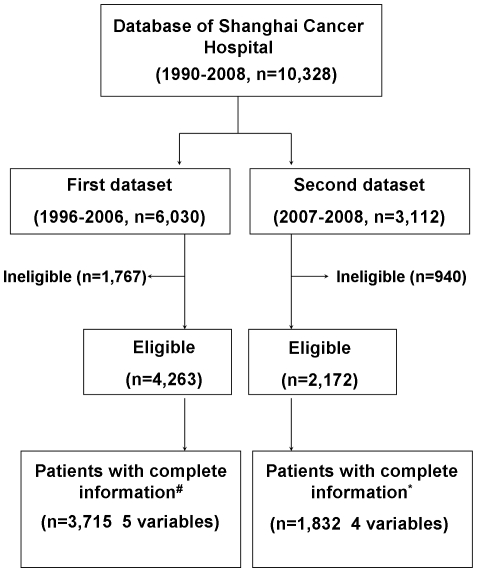
Patient selection and patient subsets analyzed.# 5 variables denote lymph node, age, pathology, tumor size, and subtype * 4 variables denote lymph node, age, pathology, and tumor size.